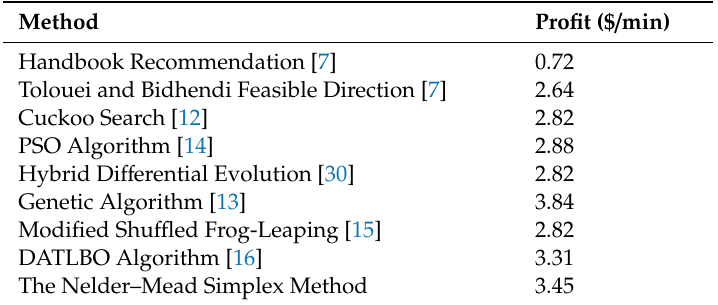
Table 13. Profit of each